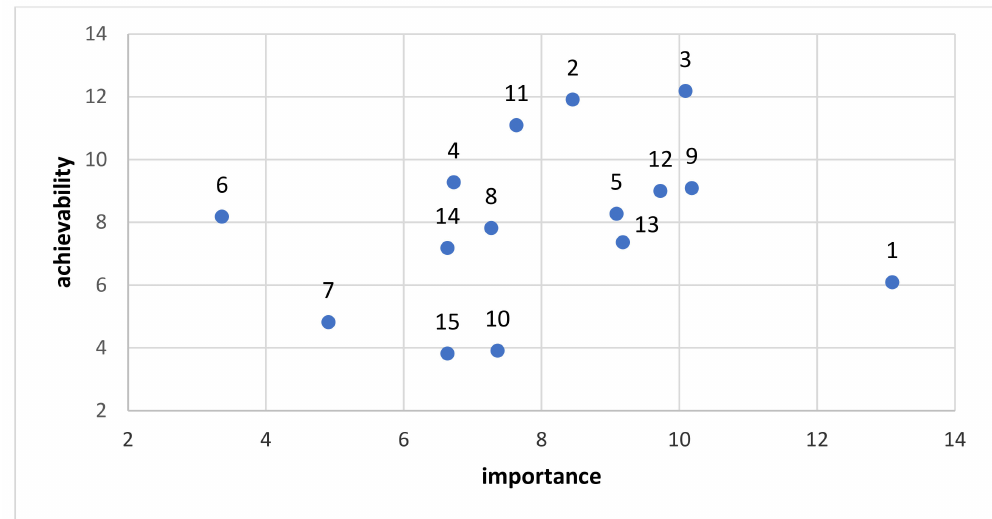
Figure 6. Recommended infrastructure support actions with details regarding importance and achievability (no weighting). The numbers in the diagram have been determined in accordance with the information on the numbers appointed to recommended actions (see Table